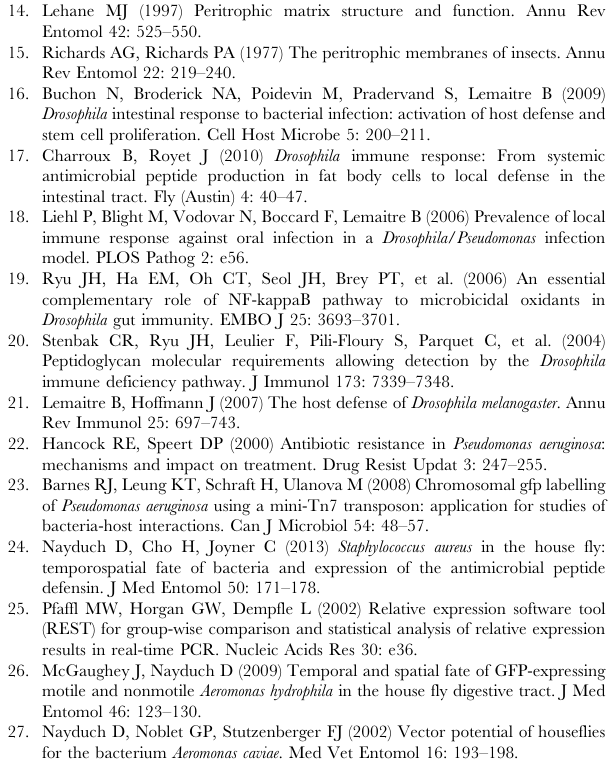
Table S3 Tissue-specific antimicrobial peptide expres- sion analysis using REST-MCS (cid:1) . House flies (n= 30 in each of two replicates) were fed an average of 6.6 6 10 4 CFU GFP- P. aeruginosa and processed as described in the text. A pairwise fixed allocation randomization test was performed using REST-MCS H to analyze AMP gene expression. P-values are for comparison to the calibrator state using the reference gene rps18 . Statistically significant P-values are shown in yellow. Red and blue represent upregulation and downregulation of target genes,